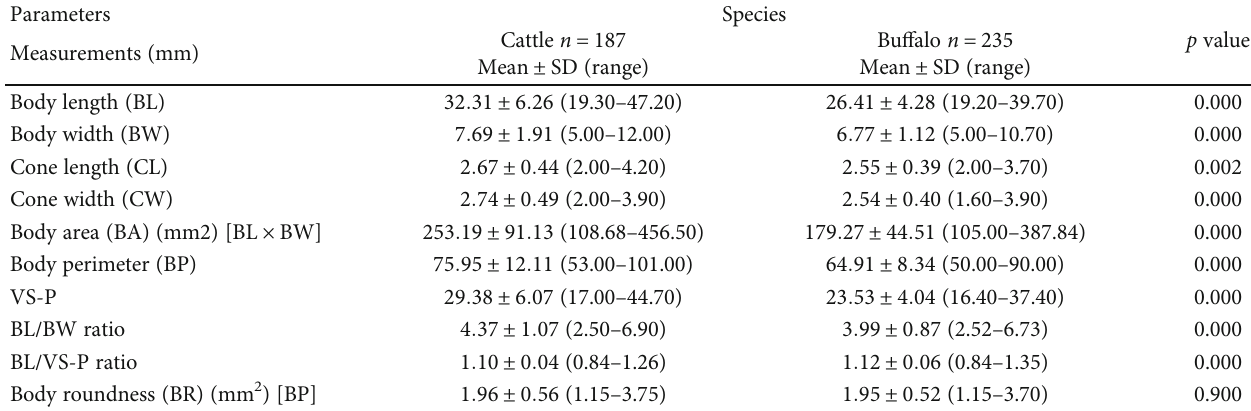
Table 2: Comparative morphological data of liver fl ukes for cattle and bu ff alo from Banting, Shah Alam, Taiping, and Ipoh abattoirs. Parameters